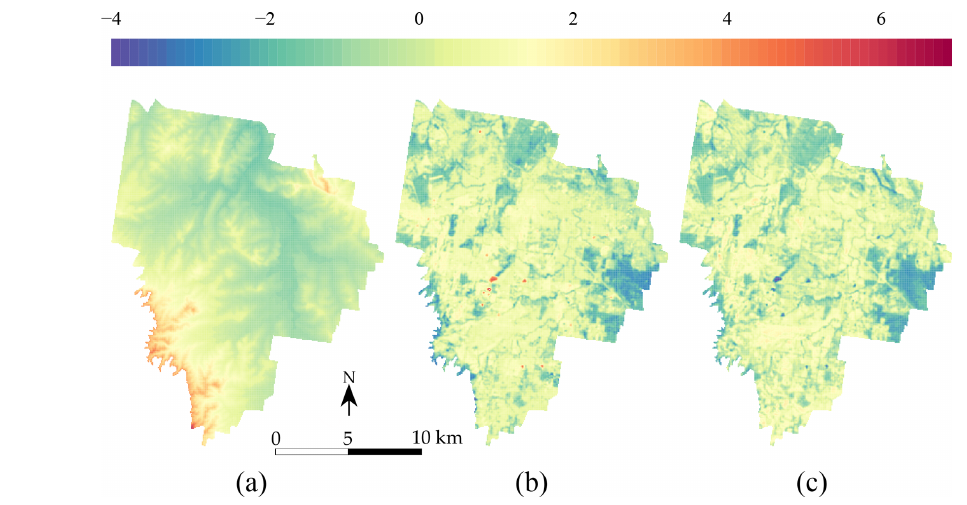
Figure 3. Standardized covariates used in model calibration (a) DEM, (b) Landsat 5 ETM band 5 and (c)